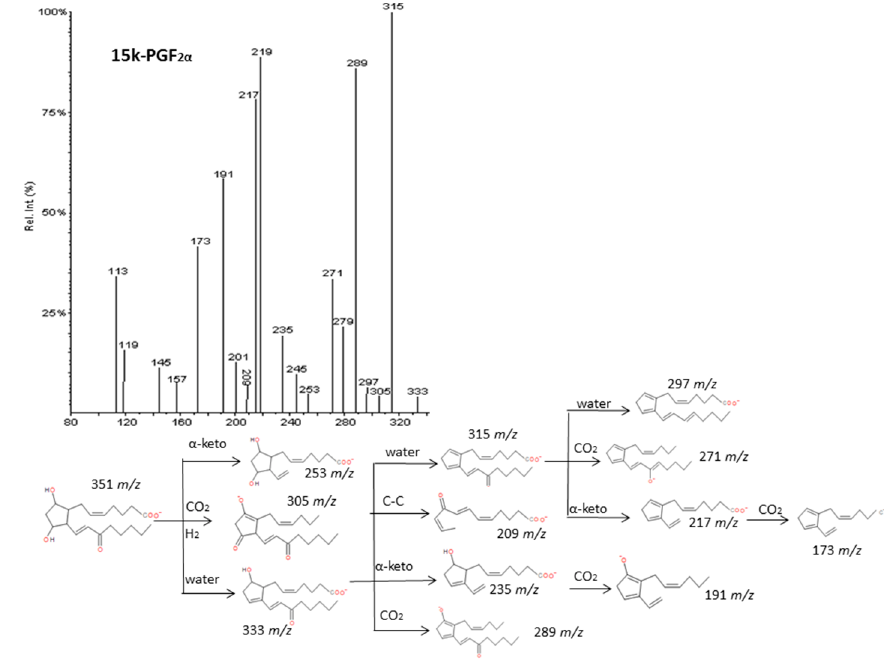
Figure 9. Fragmentation pattern suggested for 15k-PGF 2 α . The product ion spectrum at m/z 351 was obtained from the LIPID MAPS database at CID 30V.